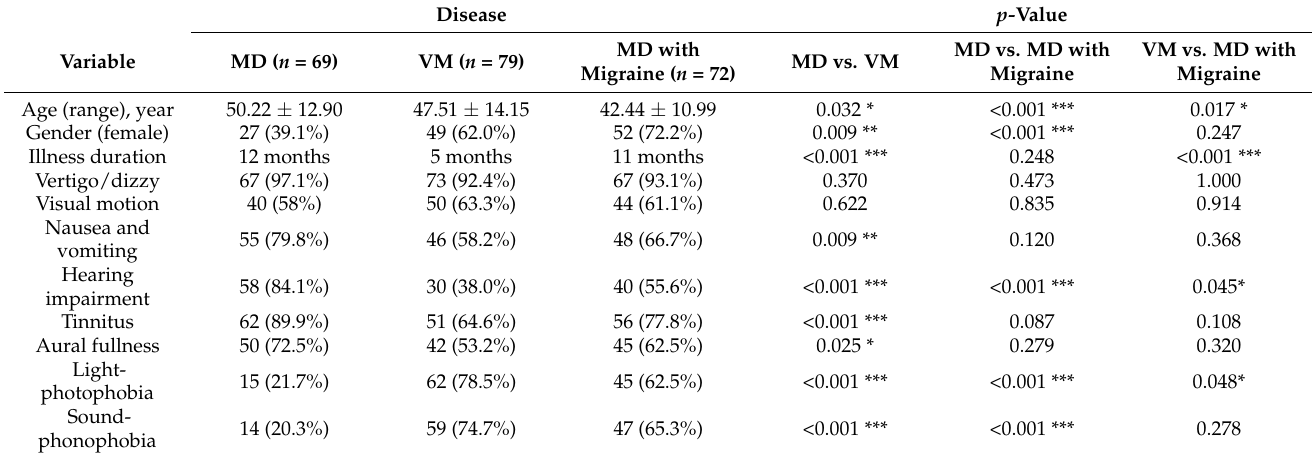
Table 1. Demographic characteristics of patients in the three diagnostic